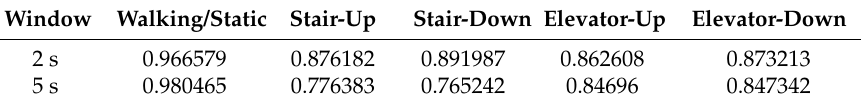
Figure 11. Statistical PCR probability distributions and model estimation at different motions. ( a ) 2 s sliding window, ( b ) 5 s sliding window. Table 6. Correlation coefficients in different motions with 2 and 5 s sliding